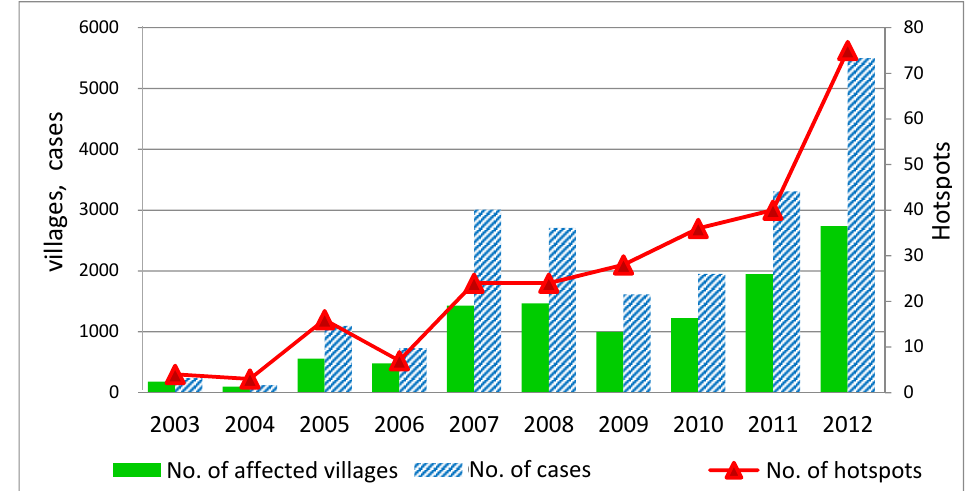
Figure 10. Number of affected villages, number of cases and number of hotspots in the upper north of Thailand during